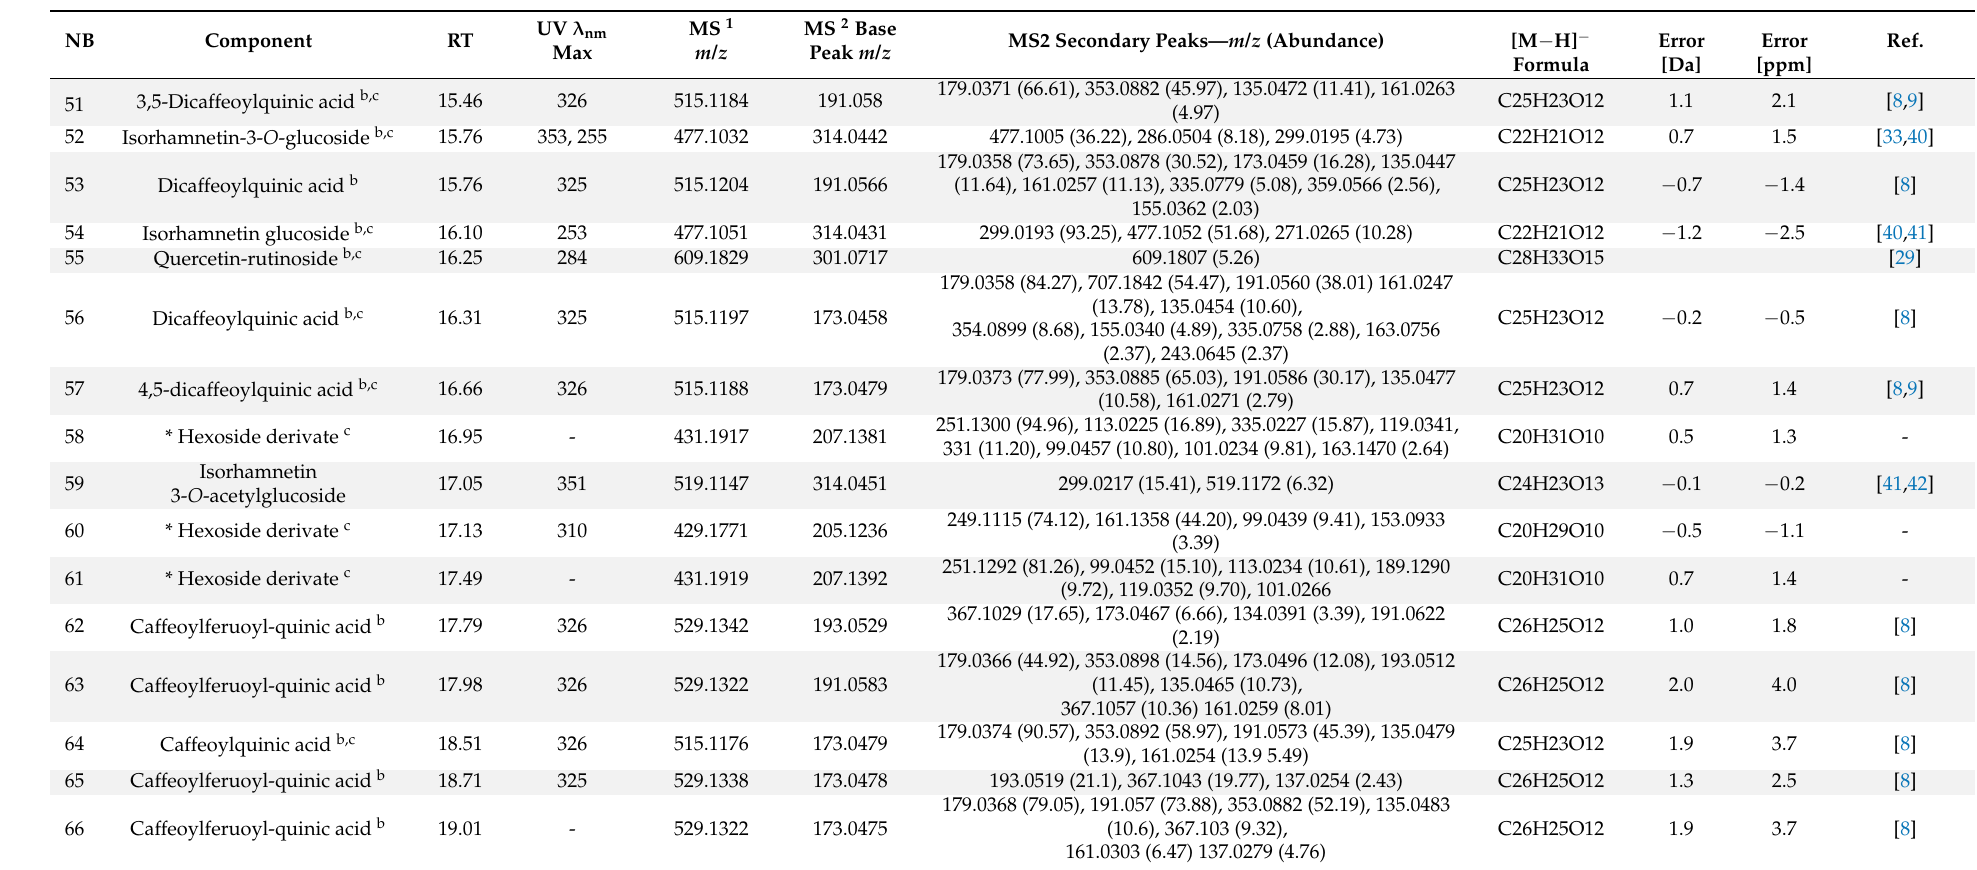
Table legend; NB—number; RT—retention time; [M–H+] − formula—calculated experimental deprotonated molecular formula; * tentatively identyfied component (lack of accurate spectral literature